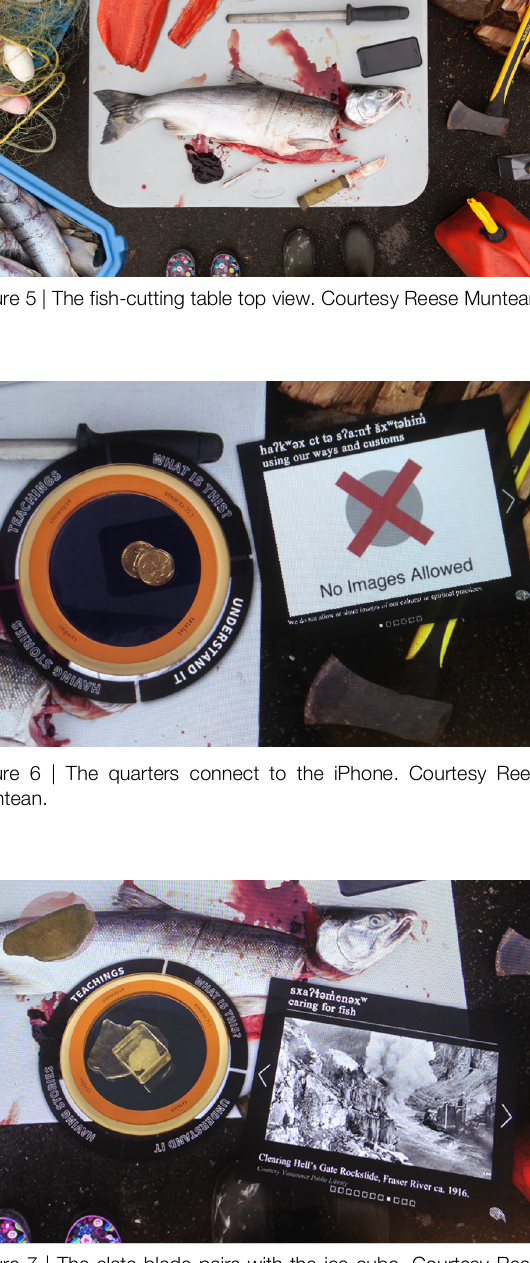
Figure 7 | The slate blade pairs with the ice cube. Courtesy Reese